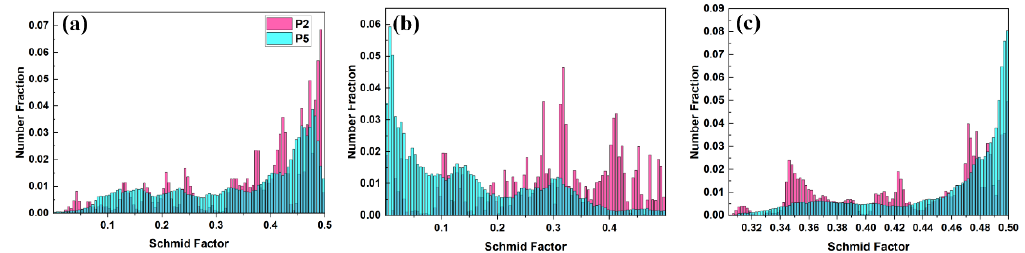
Figure 14. The Schmid factor at P2 and P5: ( a ) the basal slip, ( b ) the prismatic slip, ( c ) pyramidal <c + a>